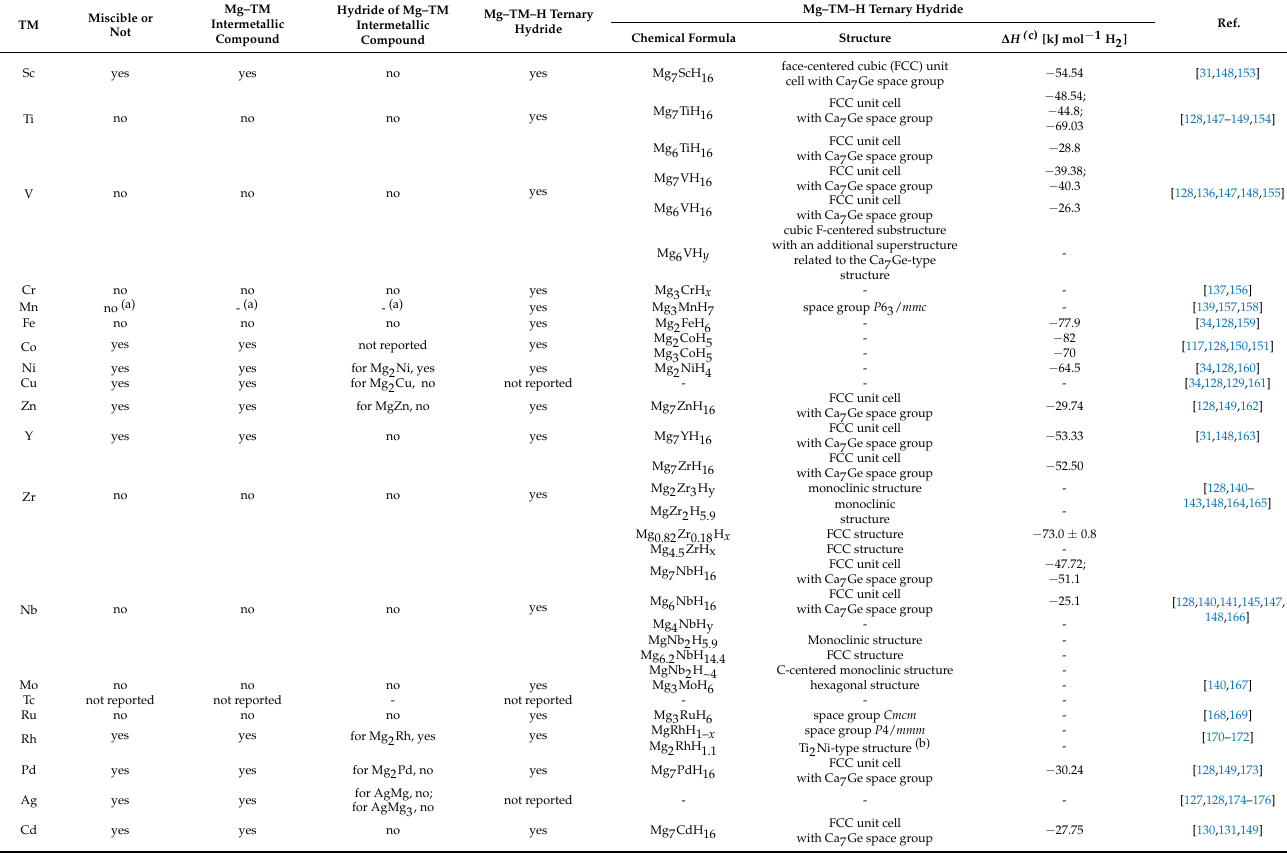
Table 3. Mg–TM alloy and Mg–TM–H system under thermodynamic equilibrium